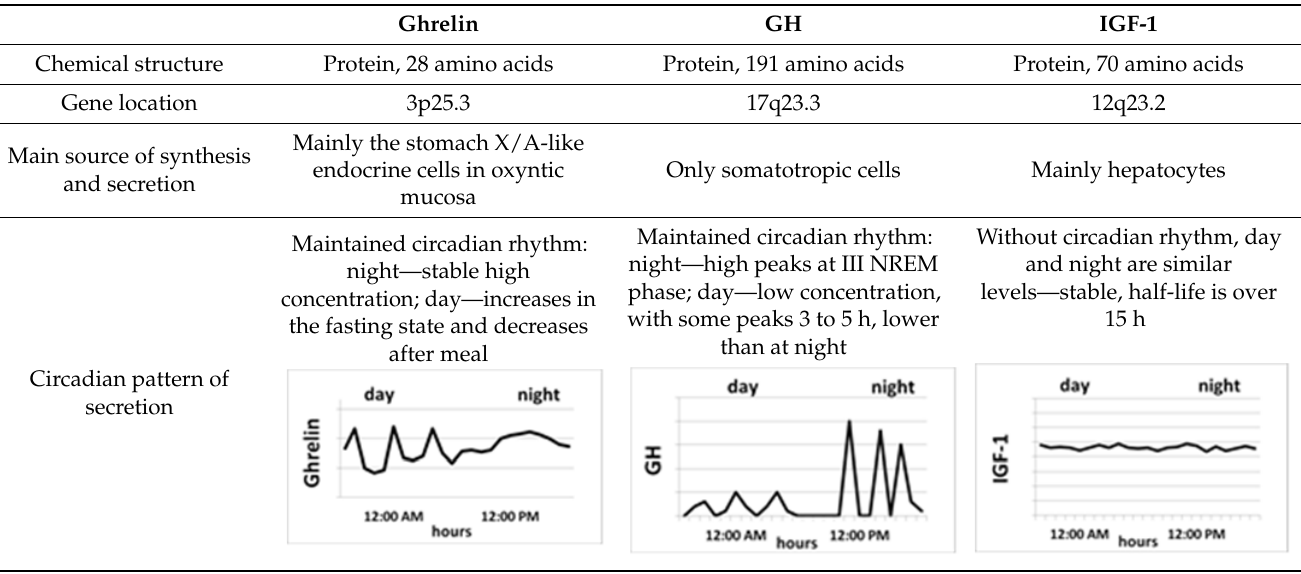
Table 1. Characteristics of the structure of ghrelin, GH and IGF-1, their receptors and patterns of